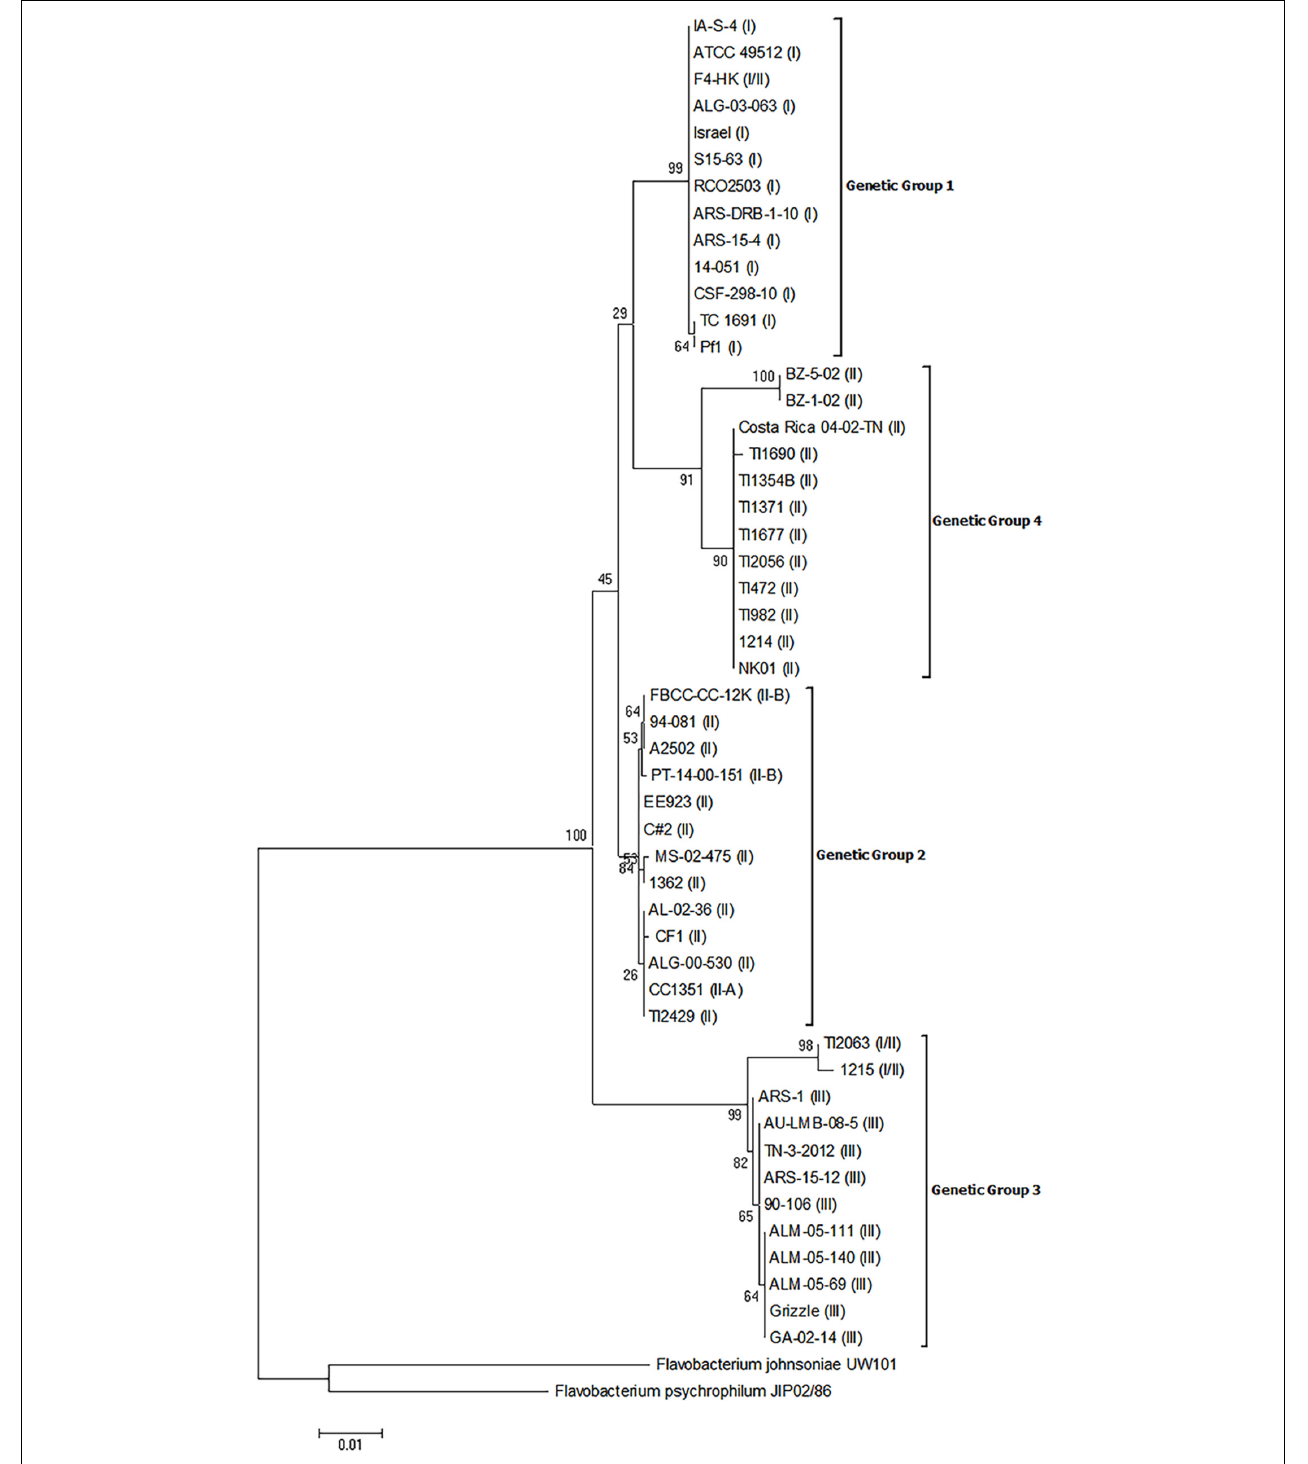
FIGURE 1 | Phylogenetic relationships based on 16S rRNA gene sequences of 50 isolates of Flavobacterium columnare . Relatedness was inferred using the maximum likelihood method based upon the Kimura 2-parameter model (K2+G) and rooted with F. johnsoniae and F. psychrophilum . The percentage of trees in which the associated sequences clustered together in the bootstrap test (1,000 replicates) is shown next to the branches. The analysis involved 52 nucleotide sequences, all positions containing gaps and missing data were eliminated, and there were a total of 1,338 positions in the final dataset. The assigned genomovar of the isolate is in parentheses adjacent to the isolate